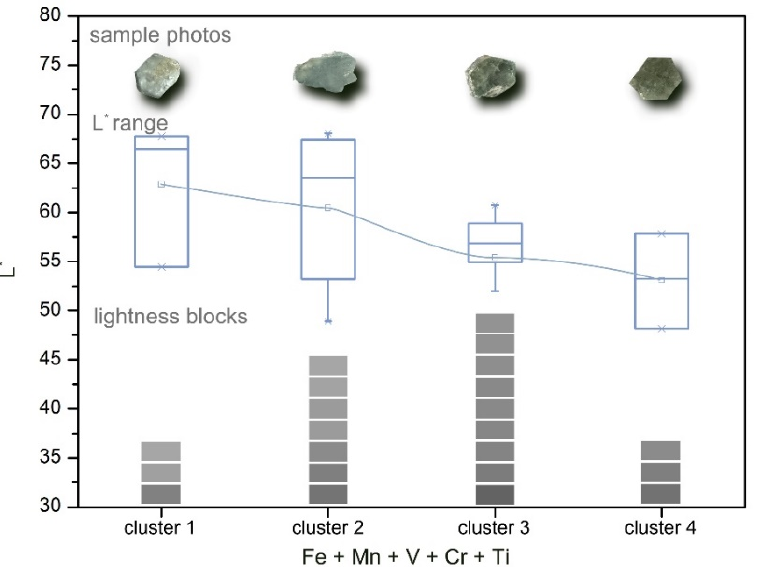
Figure 14. Box diagram of the relationship between the transition metal element content and L*; every blue box represents parameters L* in the different groups divided by K-means clustering; simulation blocks of lightness in each group are shown on the bottom, which gets from light to dark with the transition metal element content increasing; representative sample pictures of every group are shown above.